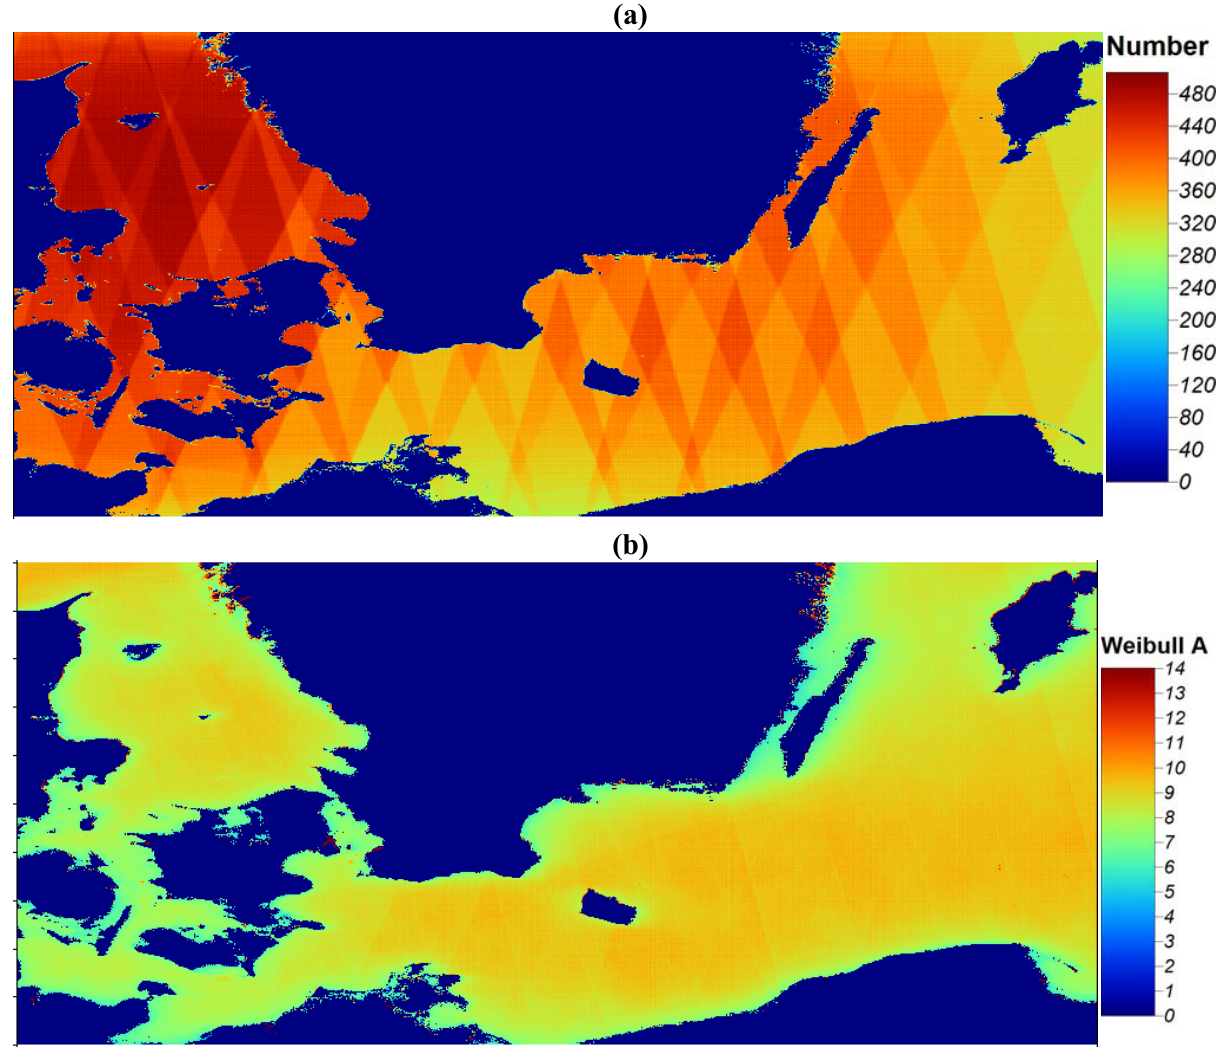
Figure 7. Wind resource statistics based on 1009 Envisat ASAR wide swath mode satellite wind maps covering part of the Baltic Sea and interior Danish Seas. Panels top: (a) number of samples ( − ); (b) Weibull A (m s − 1 ); (c) Weibull k ( − ); and (d) wind power density (W m − 2 ) including indication of wind farms. The wind farm numbers refer to Appendix